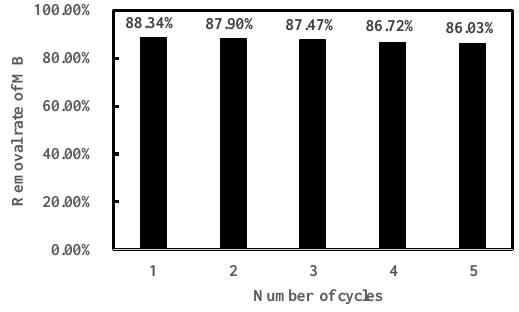
Figure 7. Photo-Fenton degradation cycle of MB on CuFe-LDH/N-CQDs.